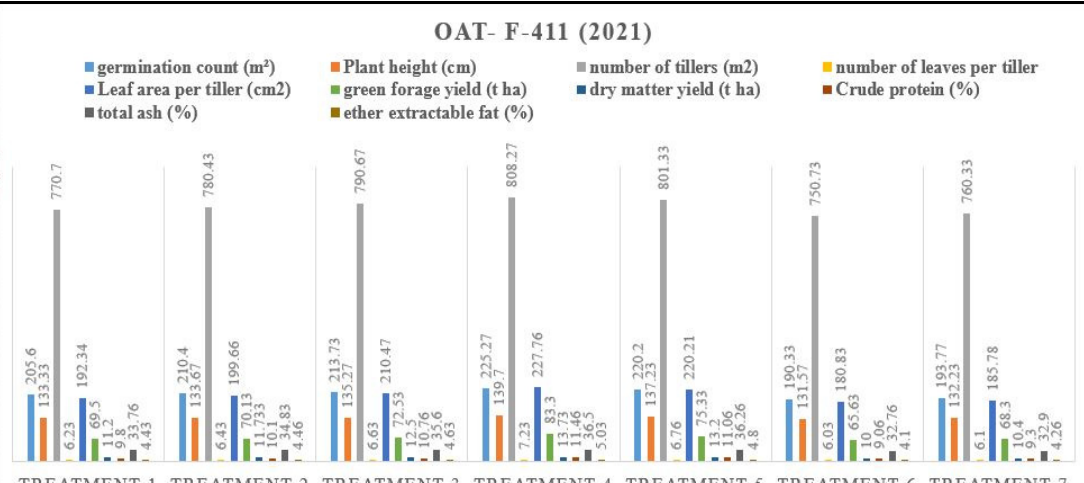
Figure 4. Effect of (INM) on oat cultivar F-411 Faisalabad.